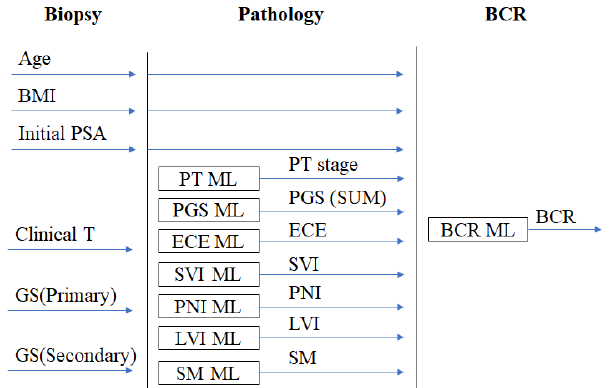
Figure 4. Structure of the ML models (machine learning: ML; body mass index: BMI; initial prostate- specific antigen: PSA; Gleason score (primary): GS (primary); Gleason score (secondary): GS (sec- ondary); extracapsular extension: ECE; seminal vesicle: SVI; perineural invasion: PNI; lymph node metastasis: LVI; surgical margin: SM; pathology T stage: PT; pathology Gleason score (SUM): PGS